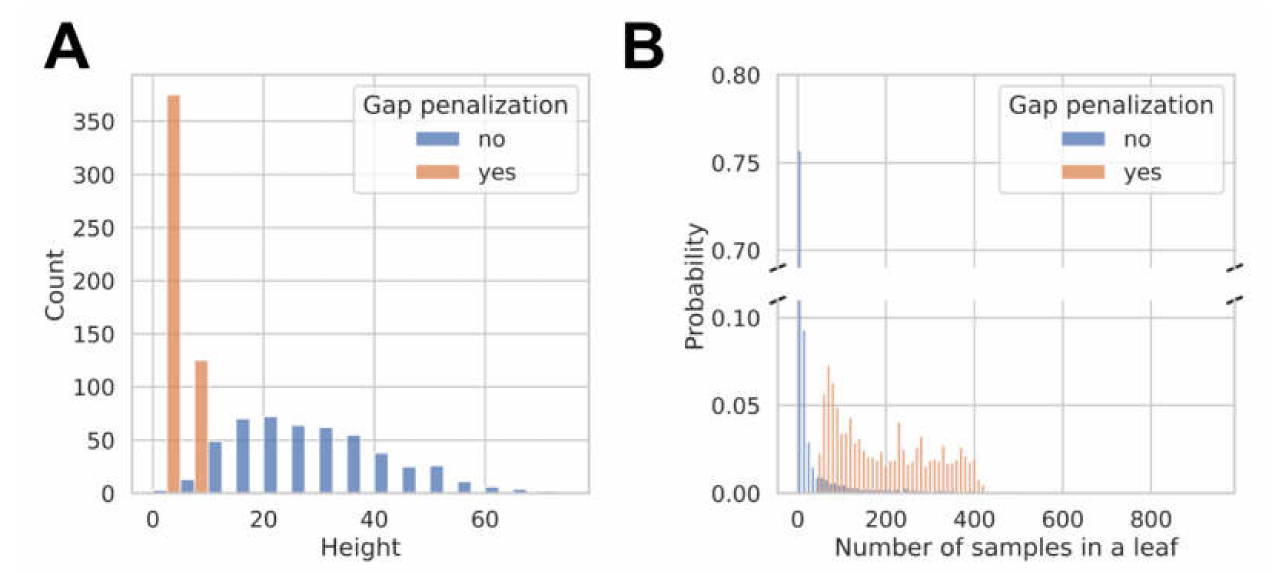
Figure 4. Comparison of an RF model optimized with (orange) or without (blue) a gap penalization term. ( A ) Number of decision trees ( y -axis) having a certain height ( x -axis); ( B ) Probability of the selection of a leaf in the RF ( y -axis) containing a specific number of training samples ( x